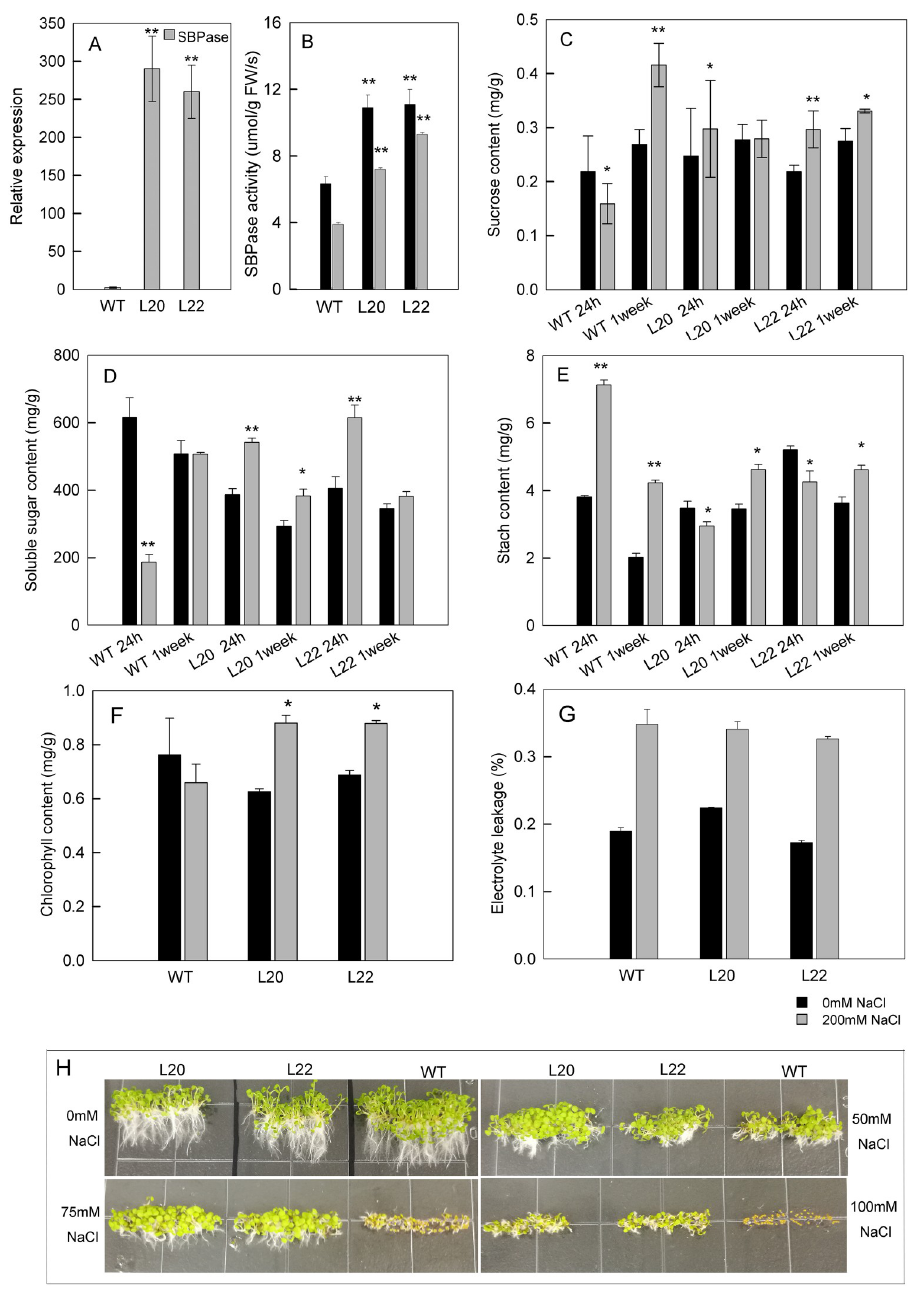
Fig 9. Overexpression of SBPase gene in Arabidopsis enhances salt tolerance by increasing the sugar and chlorophyll content. Two Arabidopsis transgenic lines (L20, L22) overexpressing the SBPase gene were generated by Agrobacterium -mediated transformation, and the SBPase activity, sucrose, soluble sugar, starch and chlorophyll content in these lines were determined. Relative electrolyte leakage was also detected. A, SBPase gene expression level in L20 and L22 transgenic lines. B, SBPase activities in L20 and L22 transgenic lines. C, Sucrose content of leaves from wild-type plants and two transgenic lines treated with salt stress for 24 h and 1 week; plants grown in normal condition were used as control. D, Soluble sugar content of leaves from wild-type and transgenic plants treated with salt stress for 24 h and 1 week; plants grown in normal condition were used as control. E, Starch content of leaves from wild-type and transgenic plants treated with salt stress for 24 h and 1 week; plants grown in normal condition were used as control. F, chlorophyll content of leaves from wild-type and transgenic lines plants treated with salt stress for 48 h. G, Relative electrolyte leakage of leaves from wild-type and transgenic lines plants treated with salt stress for 48 h. H, The seeds of WT and two transgenic Arabidopsis lines were planted on MS medium supplied with 0mM NaCl, 50mM NaCl, 75mM NaCl, 100mM NaCl respectively and cultured for 7